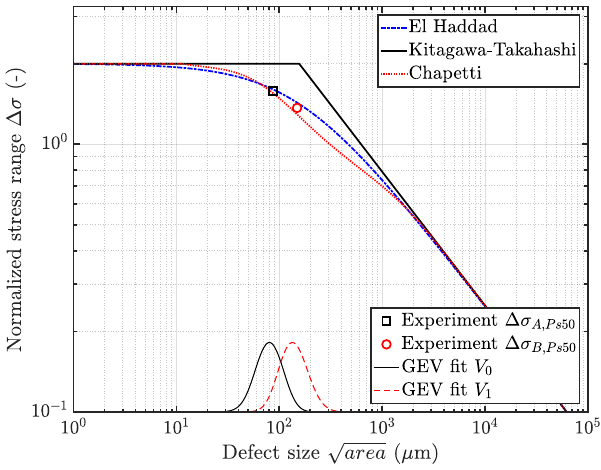
Figure 14. Validation of the fatigue assessment